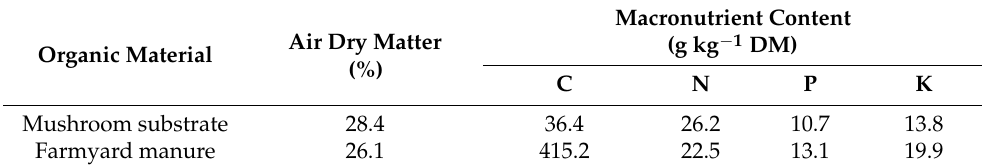
Table 2. Characteristics of organic materials used in the experiment (mean for